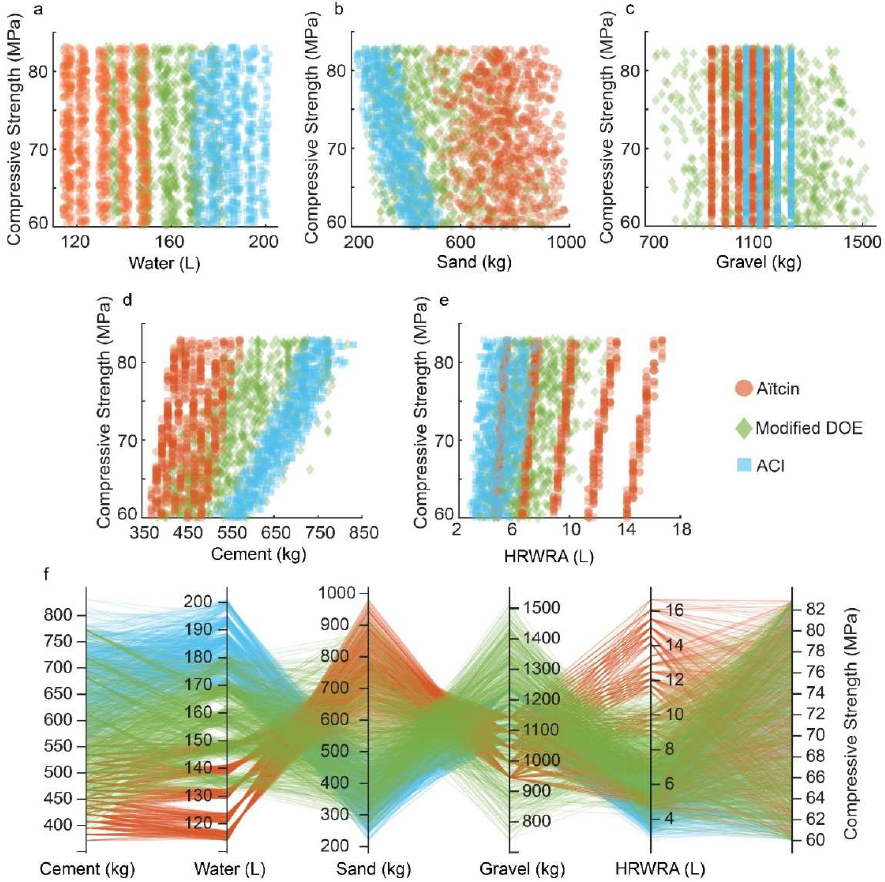
Figure 3. Visualizing the training data. ( a ) Compressive strength vs. water. ( b ) Compressive strength vs. sand. ( c ) Compressive strength vs. gravel. ( d ) Compressive strength vs. cement. ( e ) Compressive strength vs. HRWRA. ( f ) Shows the intertwinement of mix proportion when overlapped, making the determination of the mix design method based on mix ingredients a difficult task.